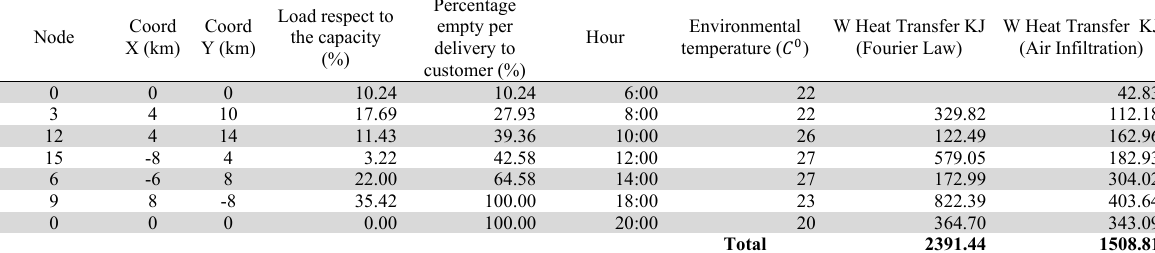
Information of the route